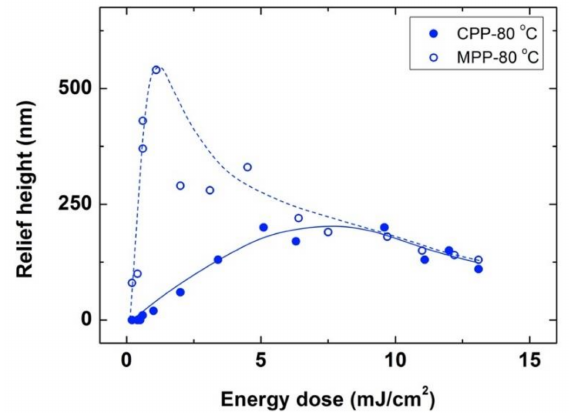
Figure 4. Relief height as a function of energy dose for photoembossed gratings with a 4.5 µ m period. Figure 2. Conventional photoembossing protocol (CPP) comprising an exposure step at RT using IL The exposure step using IL (single pulse exposure and 4.5 µ m period grating) is performed either at (single pulse exposure and 9 μ m period grating), followed by a heating step to high temperature. Relief height as a function of energy dose for different temperatures: 60 °C (  ), 80 °C (  ) and 100 RT followed by a development step at 80 ◦ C ( °C (  ). Lines are drawn to guide the